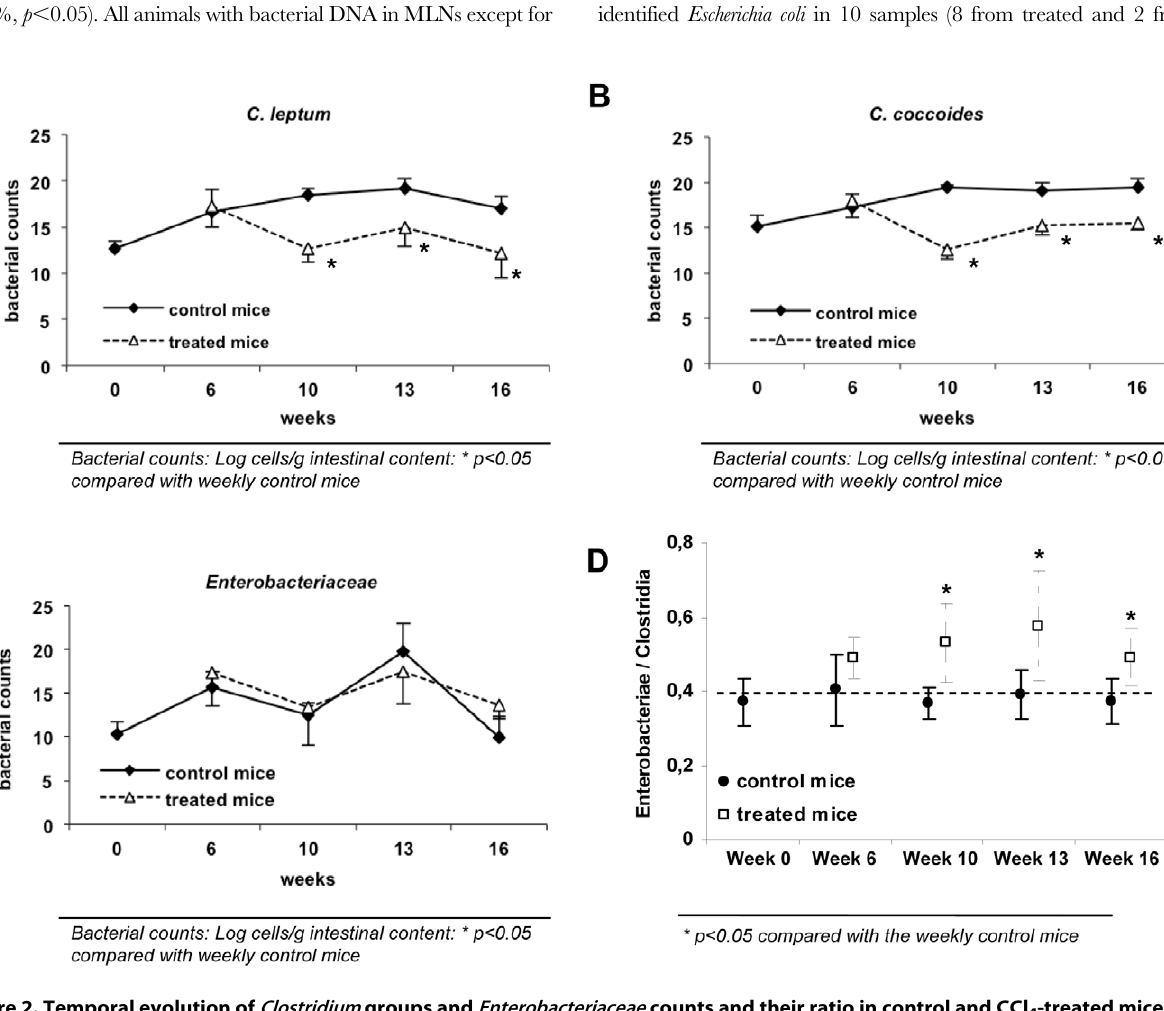
week 0 week 6 week 10 week 13 week 16 Bacterial cluster